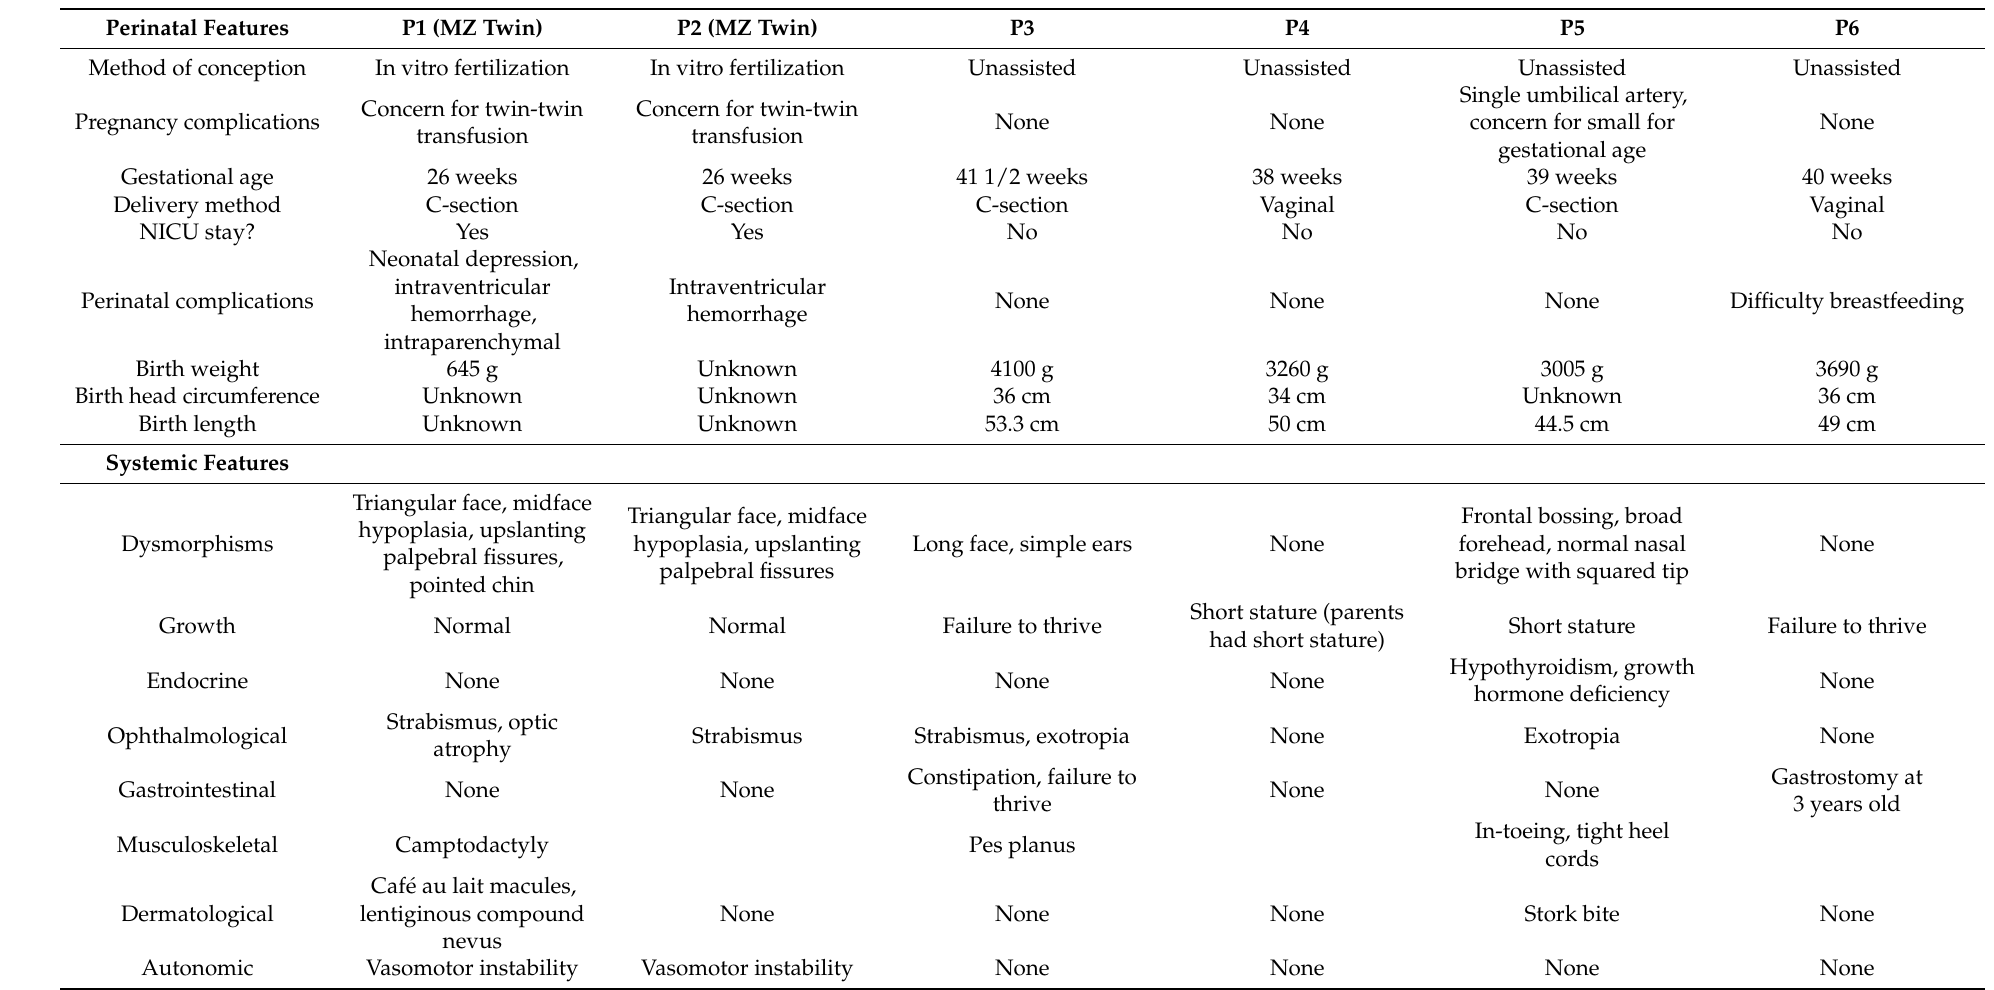
Table 3. Perinatal and systemic features of the